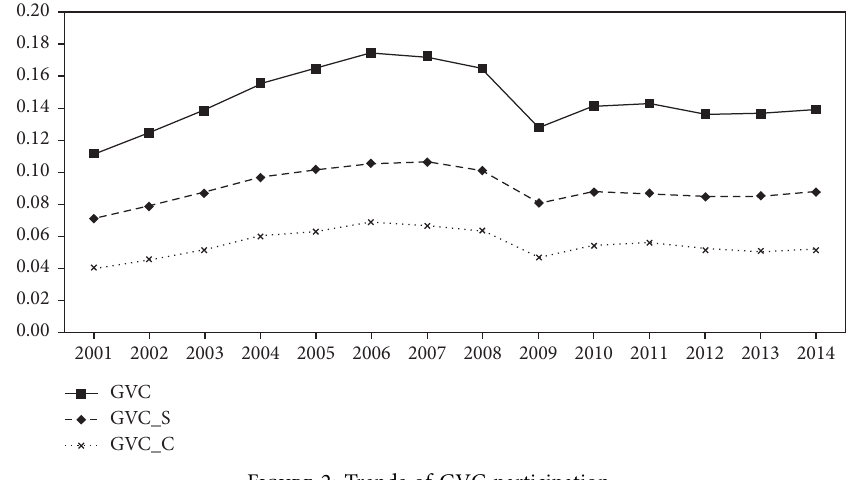
Figure 2: Trends of GVC participation.